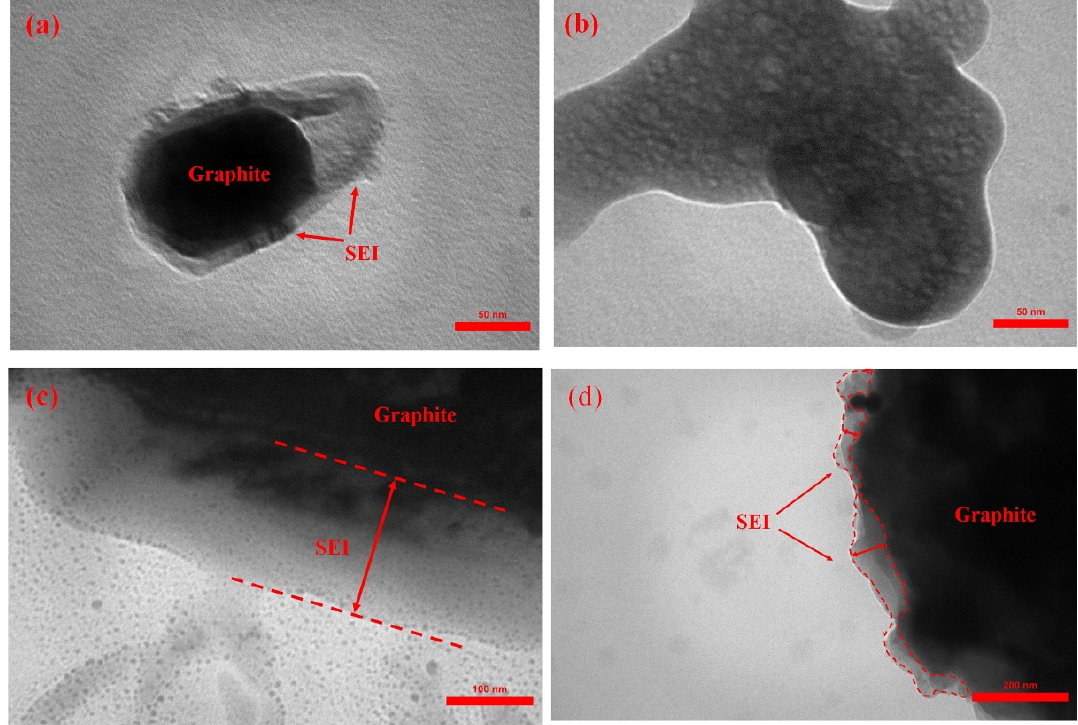
Figure 5. TEM images of the graphite electrode: ( a , c ) in the electrolyte without PMS, and ( b , d ) in the electrolyte with PMS after 5 cycles 0.1C from 0.001 to 3 V (vs. Li + /Li).